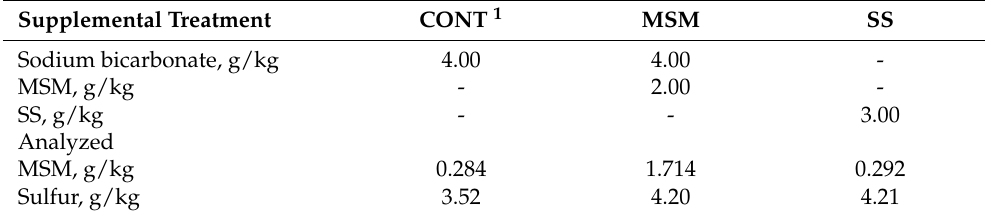
Table 2. The analyzed contents of methyl sulfonyl methane (MSM) and sulfur in the experimental diets. Supplemental